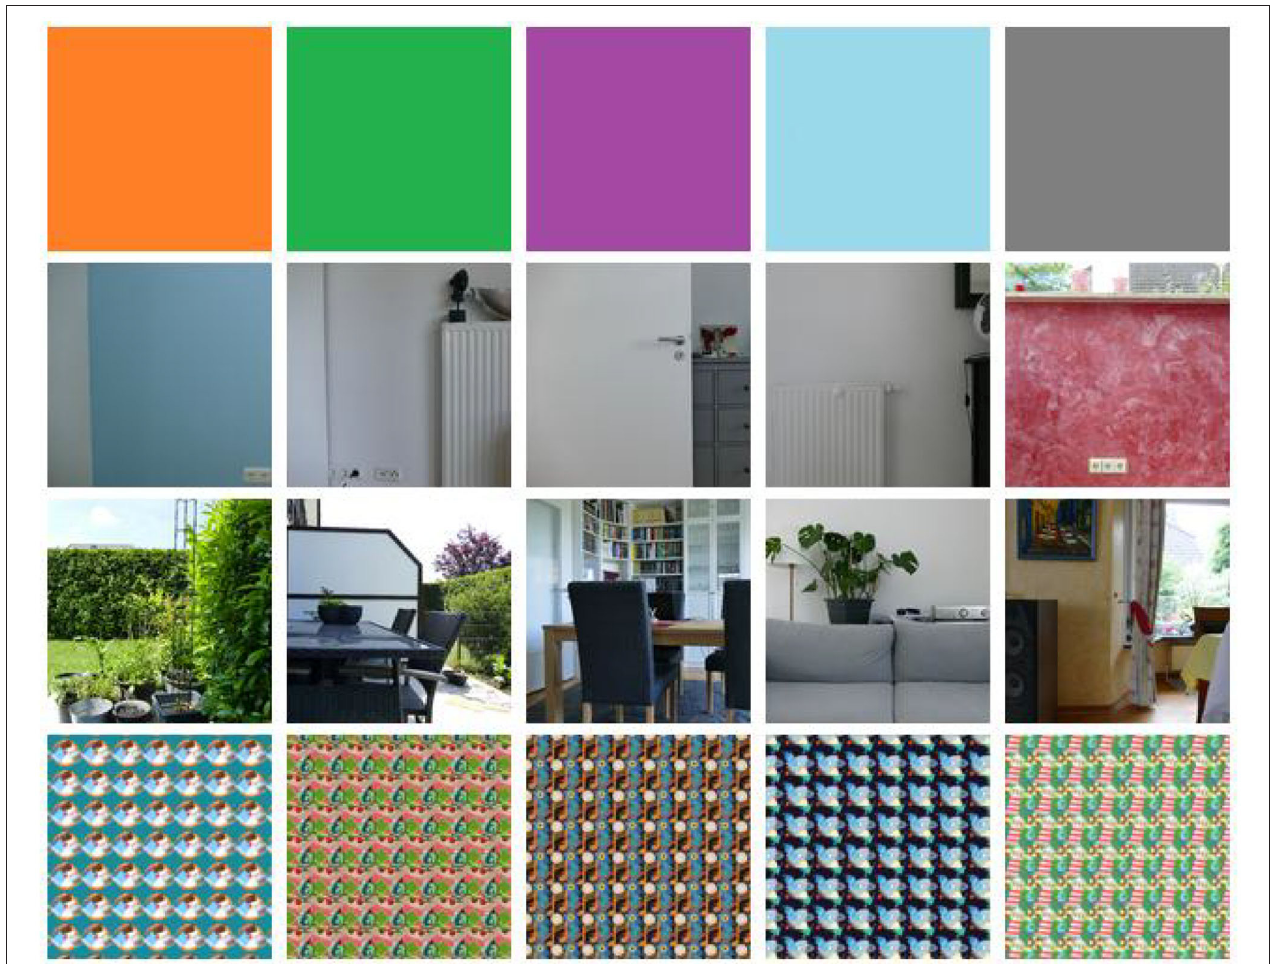
FIGURE 3 | The 20 different backgrounds of the dataset. The images are split into four complexity groups (B1, B2, B3, and B4), each shown in one row with increasing complexity from top to bottom. The first row shows the plain colored background images of B1. B2 and B3 (second and third row, respectively) are showing real-world backgrounds. A camera captured the B2 and B3 examples from a height of 89 cm. B4 (fourth row) consists of artificial background images with different colors and drawn